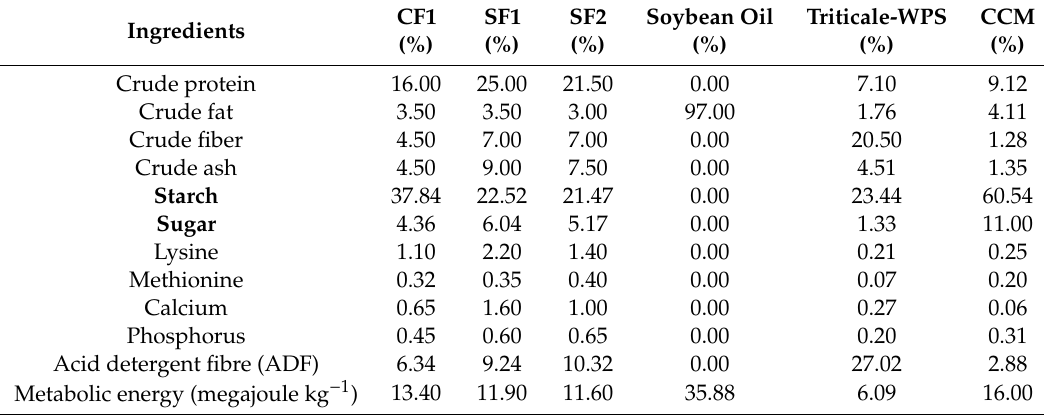
Table 1. Chemical composition of “CF1”, “SF1”, “SF2”, and “Soybean oil”, according to the declaration (88% dry matter content; DM). Triticale WPS and the Corn-Cob-Mix (CCM) were analyzed in the Institute for Animal Nutrition Hanover (88% DM) [34].